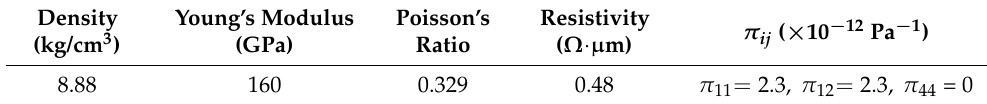
Table 2. Material properties of